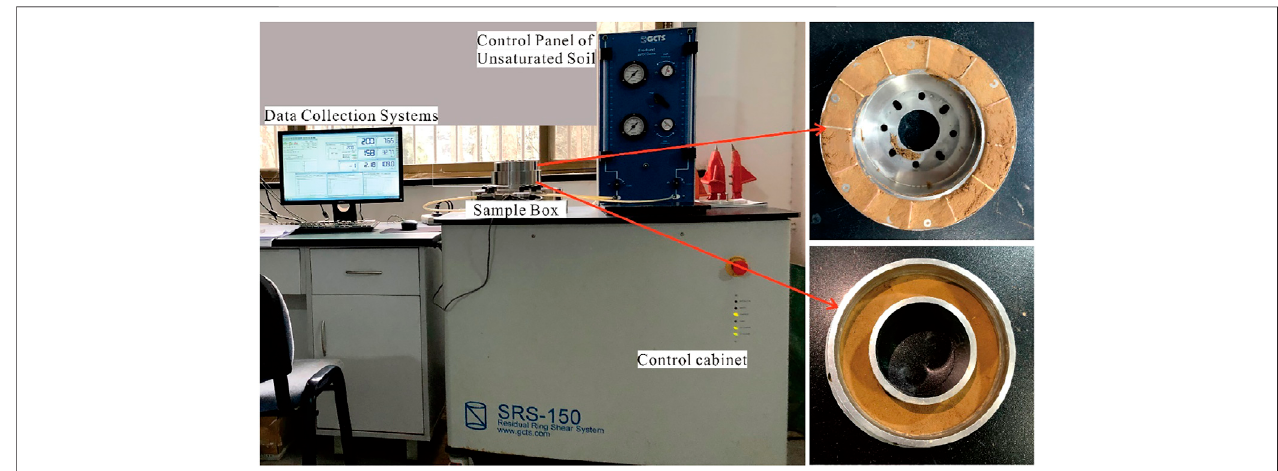
FIGURE 5 | Panoramic view of the entire SRS-150 ring shear apparatus.